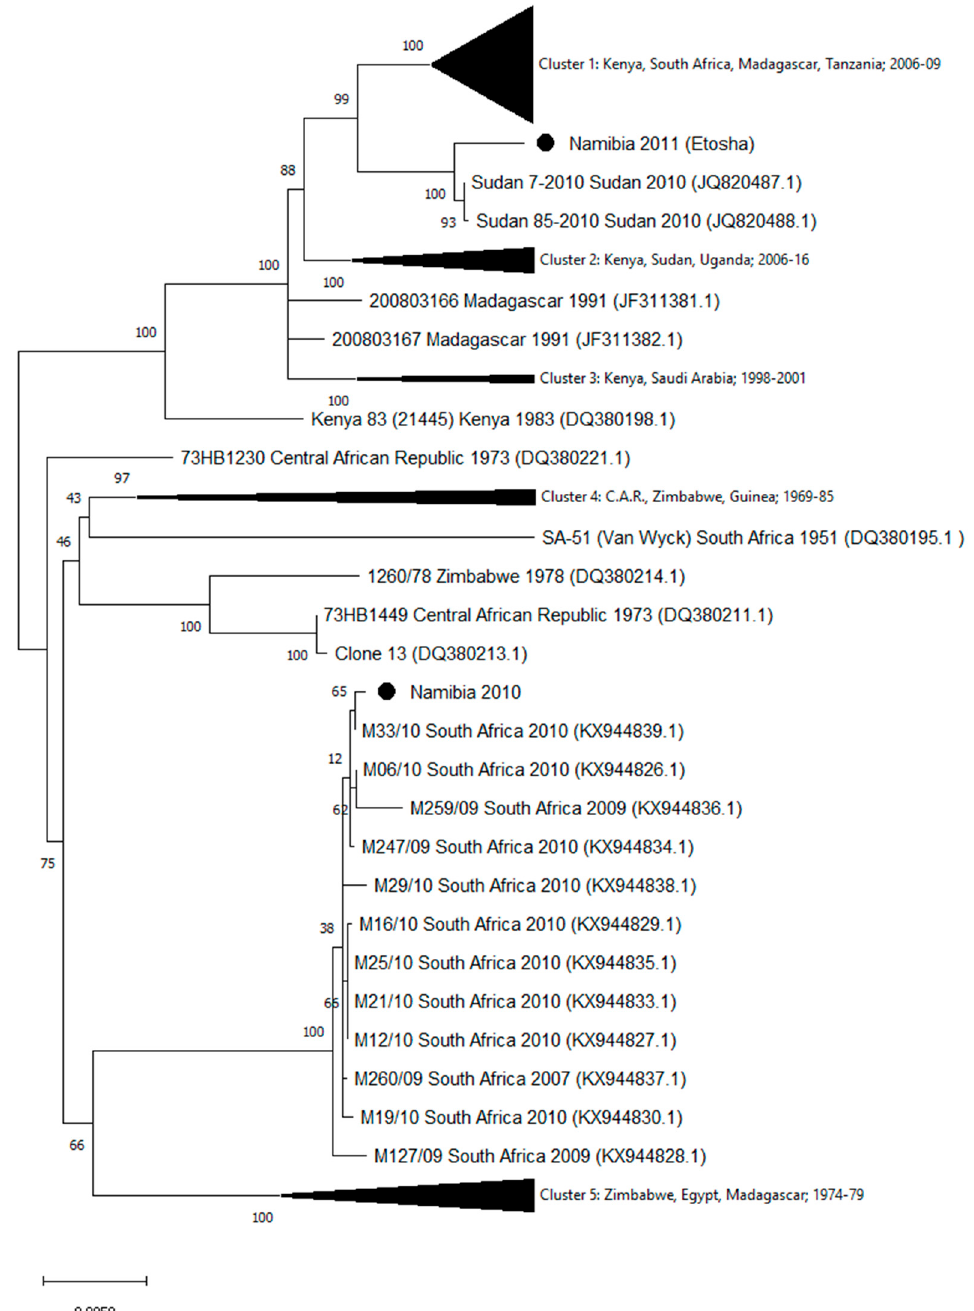
Figure 2. Phylogenetic tree of RVFV generated by the maximum likelihood method with bootstrap (500 replicates) based on 3885 nucleotides of the M genomic segment of RVFV. Analysis involved 103 nucleotide sequences available in GenBank. The compressed Cluster 1 includes 47 sequences from Kenya, South Africa, Madagascar, and Tanzania, collected in the period 2006–2009; Cluster 2: ten sequences from Kenya, Sudan, and Uganda, collected in 2006–2016; Cluster 3: three sequences from Kenya and Saudi Arabia collected in 1998–2001; Cluster 4: six sequences from C.A.R., Zimbabwe, and Guinea, collected in 1969–1985; Cluster 5: thirteen sequences from Zimbabwe, Egypt, and Madagascar, collected in 1974–1979. Strain names and accession numbers of the sequences included in the compressed clusters are listed in Table S3.